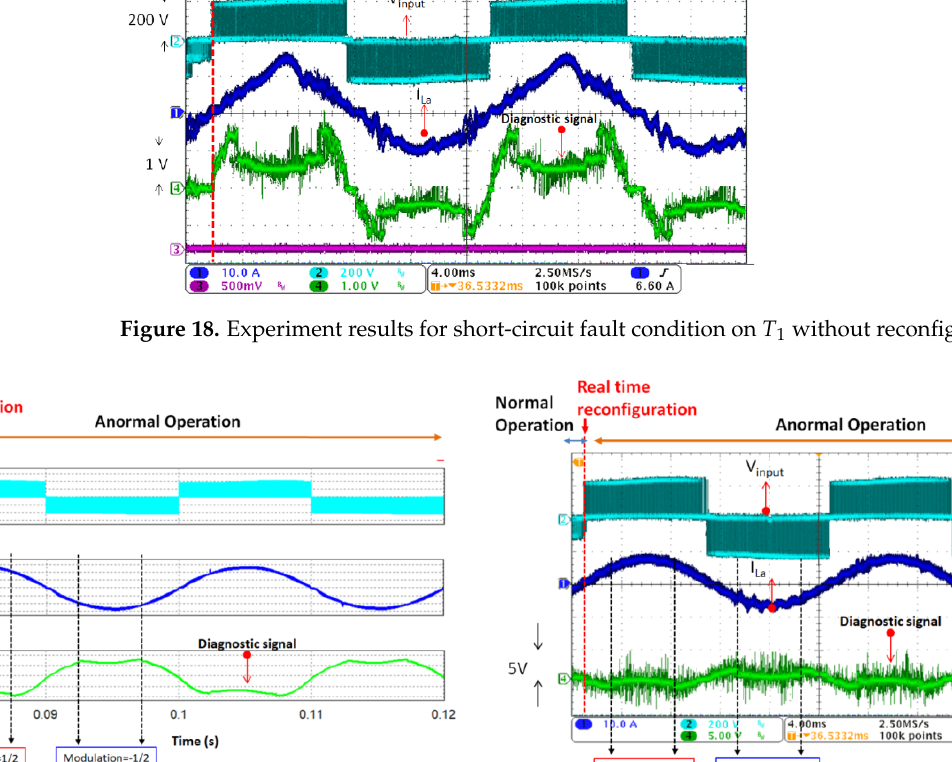
Figure 20. Experiment result for short-circuit fault condition on T 1 with the detection signal. Figure 21. Experiment result for short-circuit fault condition on T 2 with the detection signal.